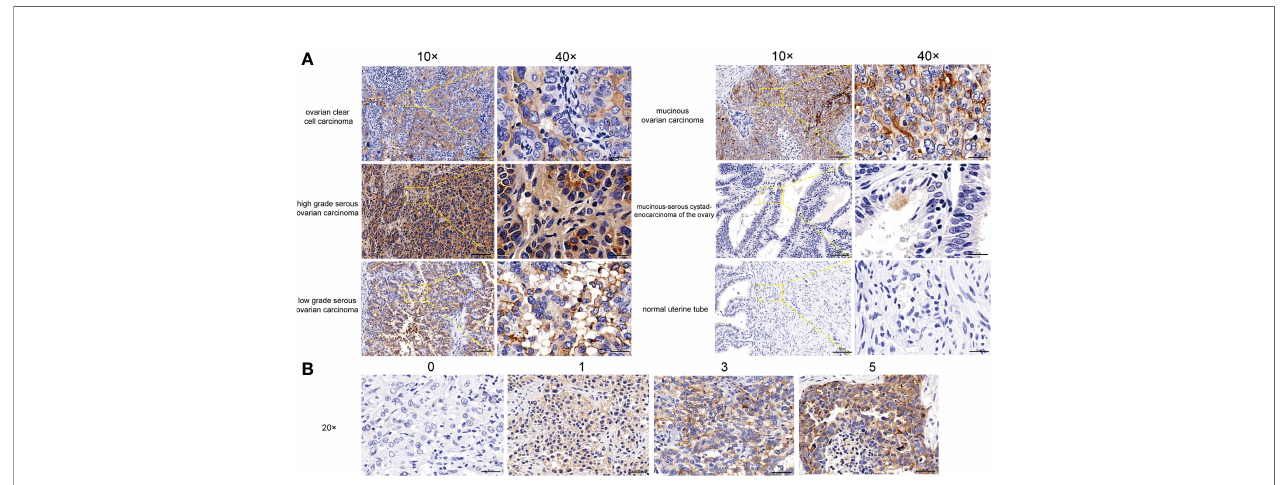
FIGURE 2 | Expression of MSLN in ovarian cancer. (A) Expression of MSLN in tissue microarray, including ovarian clear cell carcinoma, high grade serous ovarian carcinoma, low grade serous ovarian carcinoma, mucinous ovarian carcinoma, mucinous-serous cystadenocarcinoma of the ovary and normal uterine tube. (B) The immunohistochemical score is scored based on the positive rate: 0 to 5% for 0 points, 6% to 25% for 1 point, 26% to 50% for 2 points, 51% to 75% for 3 points, >75% for 5